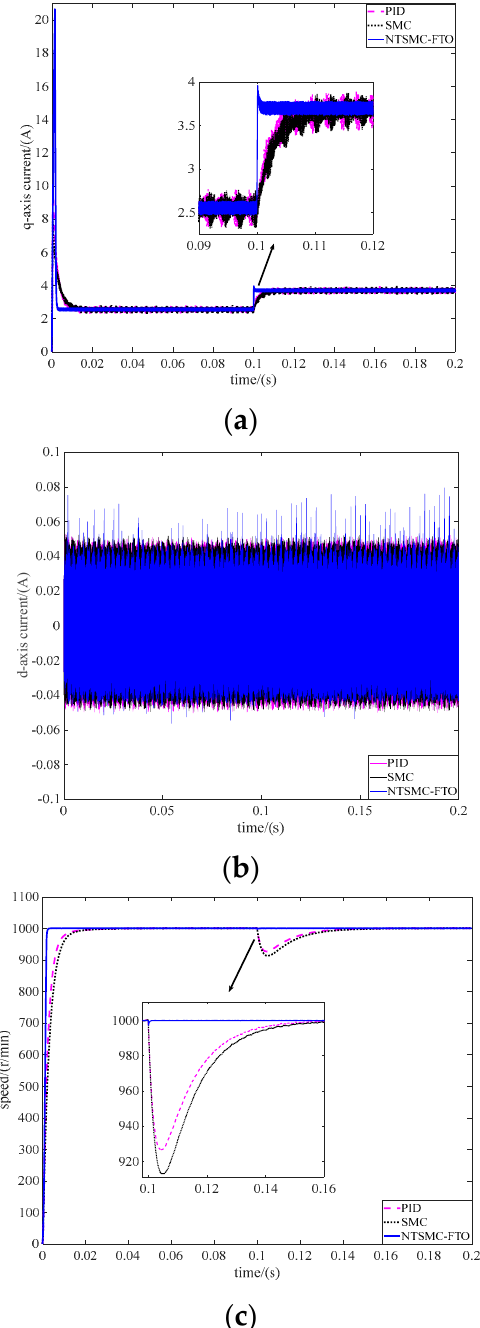
Figure 3. Performance comparisons under the PID, SMC and NTSMC-FTO with sudden load torque change. ( a ) Speed response curves. ( b ) d- axis current curves. ( c ) q- axis current curves.